Question: What caption would you write for this figure?
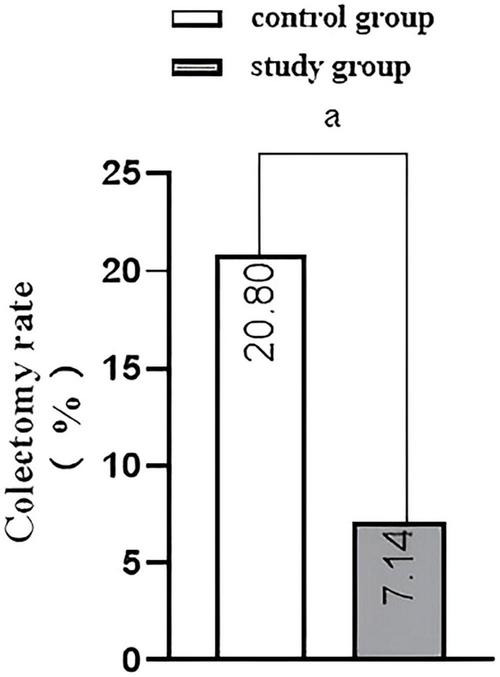
Answer: Demographic and clinical baseline characteristics of all 90 patients included in the study, n (%).